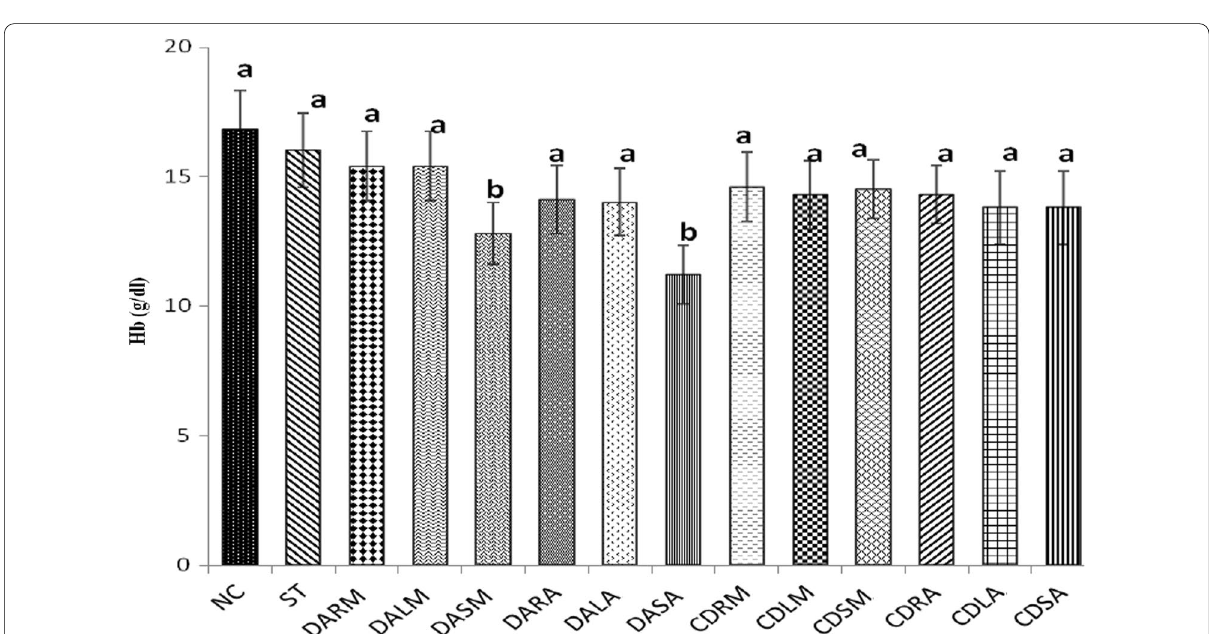
Fig. 4 Effects of methanolic and aqueous extracts of roots, leaves and stem of D. arborescens and C. dependens on Haemoglobin (Hb) of albino rats. Bars with similar alphabets are not statistically different ( p <